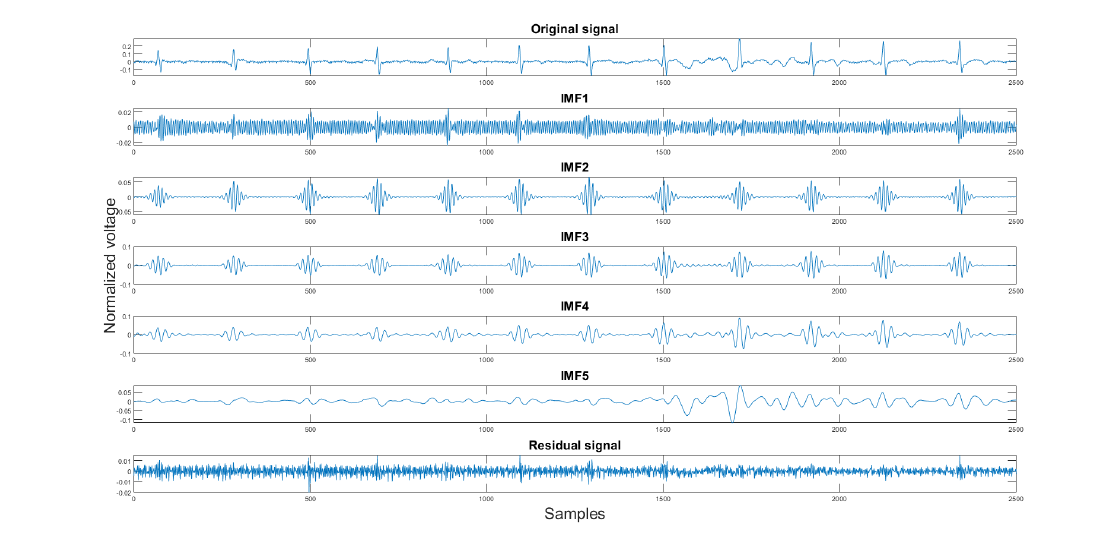
Figure 11. The original signal, IMFs, and residual signal by the VMD